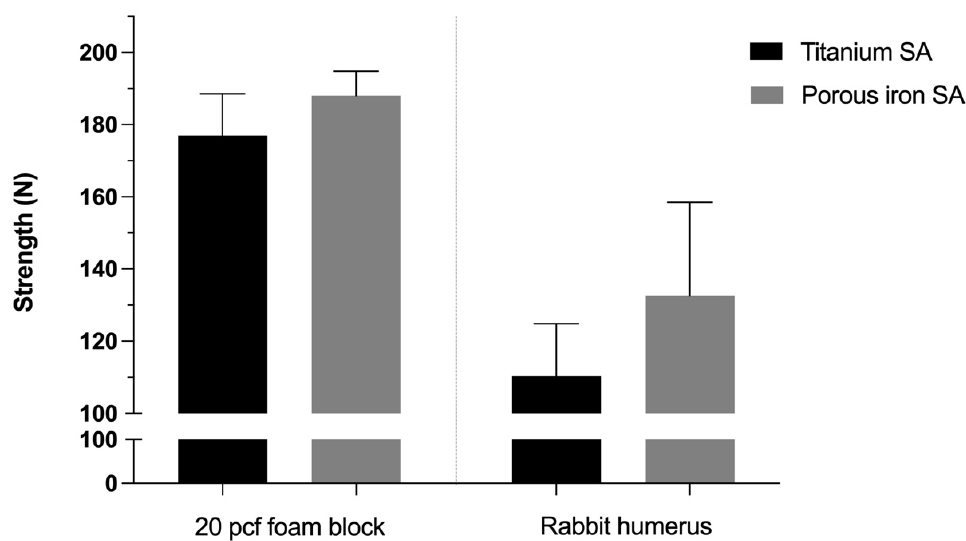
Figure 6. In vitro biomechanical ultimate pullout strength assessment for the different SAs in 20-pound-per-cubic-foot (pcf) polyurethane foam blocks and rabbit humeri. Mean ± standard error of the mean (SEM).